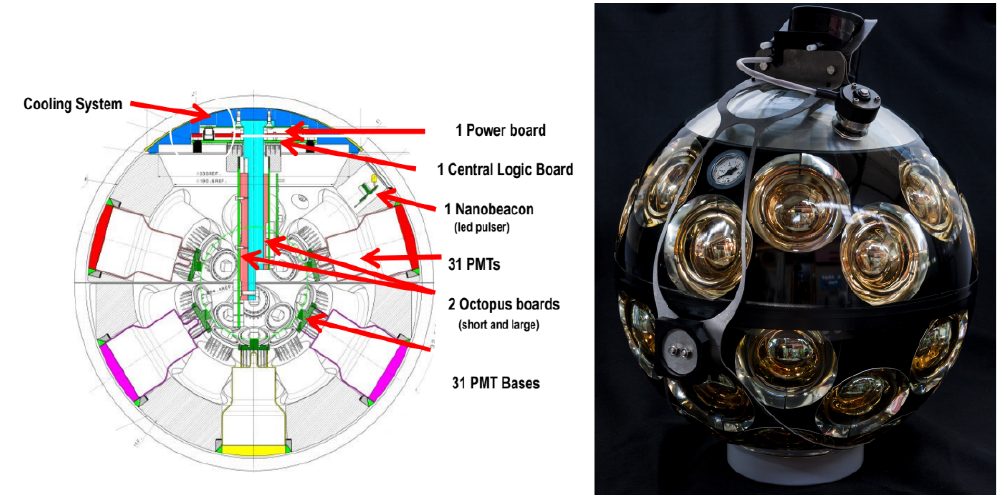
Figure 10. ( Left ) Scheme of a Digital Optical Module with the location of the acquisition electronics; ( Right ) Picture of a completed DOM. Credits: